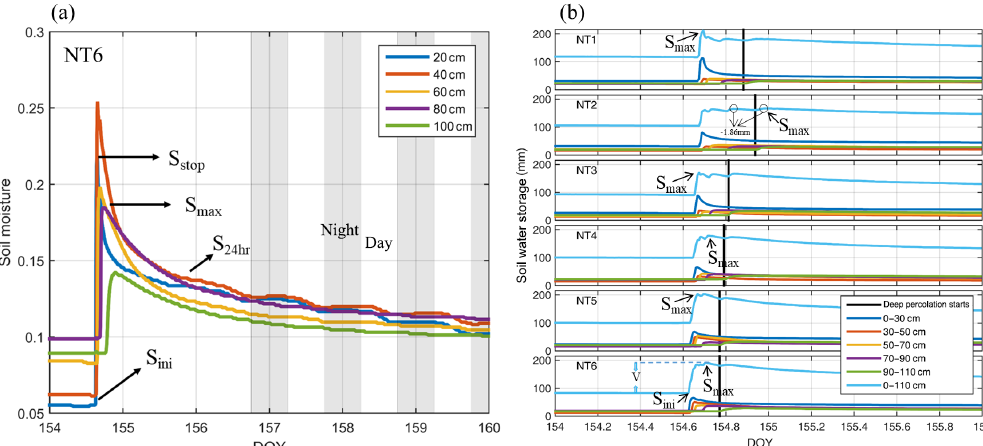
Figure 2. (a) Example diagram of the volumetric soil water content at various depths of NT6 during and after the 107.1mm irrigation event on DOY (day of year) 154–160 (2016). S stop denotes that the irrigation event ends and moisture of uppermost soil layer starts to decrease; S max represents maximum water storage and that the real water storage in root-zone soil was assumed to be equal to S max ; S 24h denotes that deep percolation ends 1d later – after this point, ET dominates the water-loss processes; S 24h would tend to approach S max if more soil moisture sensors were installed in the soil profile; S ini refers to the pre-irrigation, soil moisture minimum. The gray stripes between 156 and 160 DOY represent nights, i.e., 18:00 to 06:00LT of the next day. (b) Verification of the assumption of Eq. (2), i.e., that S max appeared before deep percolation began during the irrigation event on DOY 154–156 (2016). The black solid line represents the time that deep percolation began in each plot